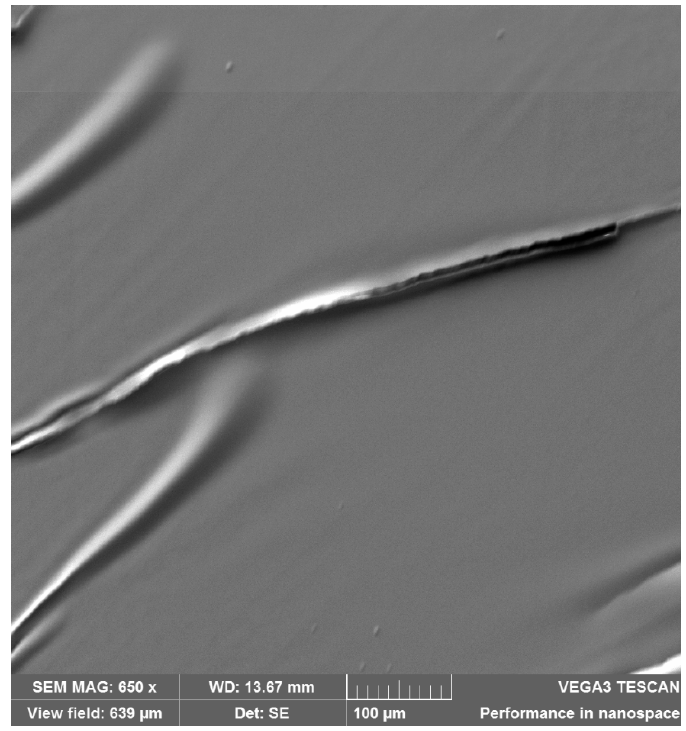
Figure 2. Scanning electron microscope (SEM) microscopic image of the dispersed silver nanoparticles on the Polydimethylsiloxane (PDMS)substrate.